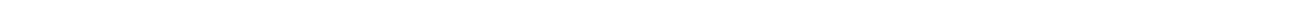
Fig. 5 OmpR regulation of intracellular pH is non-canonical. a Phosphorylation of EnvZc is acid sensitive. Phosphorylation of E. coli EnvZc compared with S. Typhimurium EnvZc at pH 7.5 and 5.5. The indicated reaction times are above the panel and the percent phosphorylation (determined by densitometry) is listed below. b Representative epi fl uorescence ratio images (R 488/440 ) were obtained for wild type, an ompR null, an envZ null strain, and the envZ null complemented with envZc (encoding the cytoplasmic domain of EnvZ), and an envZ null complemented with envZcC277Y in S . Typhimurium. Cells were incubated at either acidic pH e 5.6 or pH e 7.2 in the presence of 15% (w/v) sucrose. Scale bar, 3 µ m. c A plot of the intracellular pH of 50 cells of wild-type and S . Typhimurium mutants at each indicated time point. Error bars represent the mean ± s.e.m. ( n = 3). d , e OmpR binding to DNA is pH sensitive. AFM images of the 700 bp ompC promoter ( ompC 700 ) from d S . Typhimurium and e E. coli with 30 nM OmpR at acid pH and at neutral pH (the pH used was from the measured values in Fig. 1), 30 nM OmpR~P (phosphorylated by acetyl phosphate), and 30 nM (EnvZc + OmpR) at different pH e values. The lengths of the ompC promoter in S . Typhimurium and E. coli were similar (Supplementary Fig. 9h,